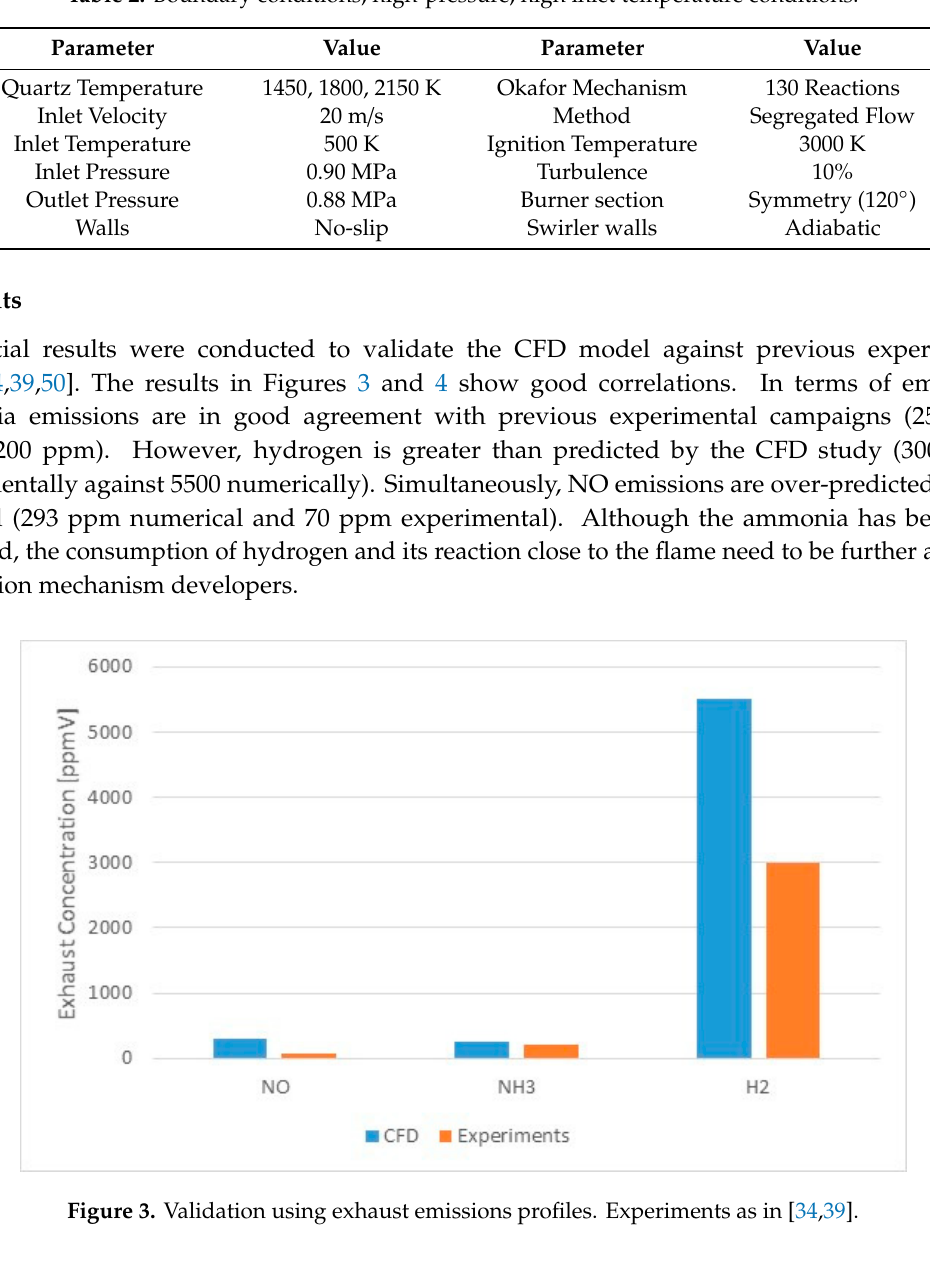
Figure 4. Isothermal results. ( Left ) Experiments from [50]; ( right ) numerical analysis (zone of interest highlighted). Velocity magnitudes (in the shearing flow and CRZ) and location of the coherent structures are extremely close between cases. The model in Figure 5 shows that it is under high temperatures >1700 K that unburned ammonia is decomposed into hydrogen after the flame. Also, NO is heavily found close to the flame front, as expected, with a decreasing concentration immediately after the breaking down point of unburned ammonia, a consequence of deNoxing effects caused by the interaction with NH 2 produced from NH 3 in the presence of OH. Recirculation patterns next to the wall (as seen in Figure 4) create higher concentration areas of NO emissions after the flame, but further formation of NO is limited in this region. Interestingly, NO reduction occurs at various temperatures above 700 K behind the flame in locations where external recirculation zones exist (Figure 6) and locations where unburned ammonia is also present, thus confirming the previous assertion.